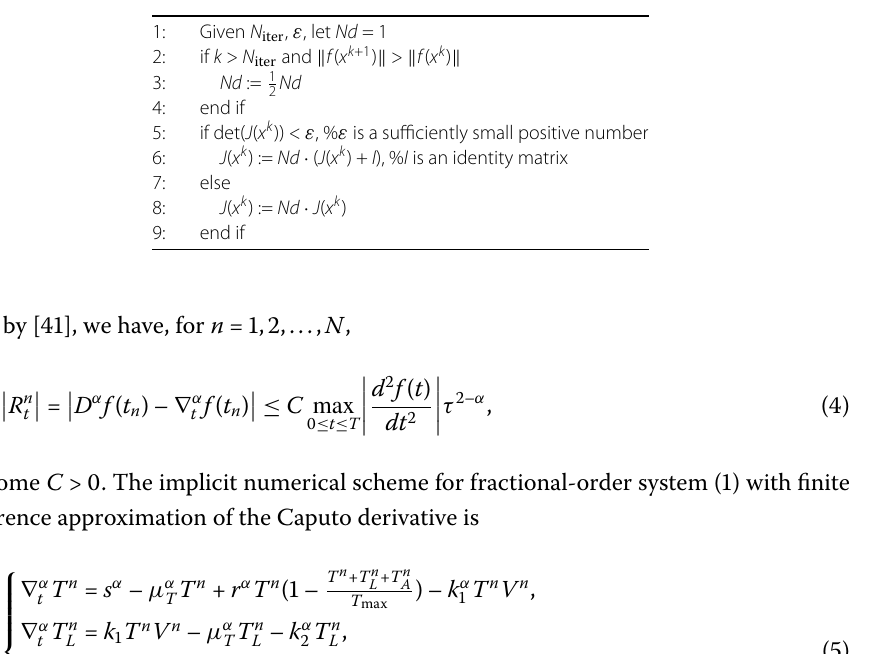
Algorithm 1 A modified Jacobi matrix on Newton iteration